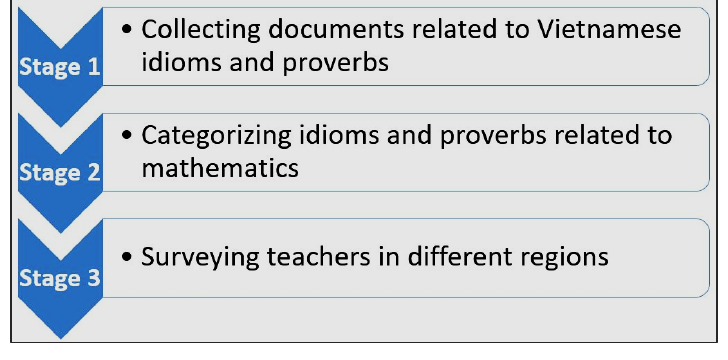
Figure 1. Stages of the data collection procedure